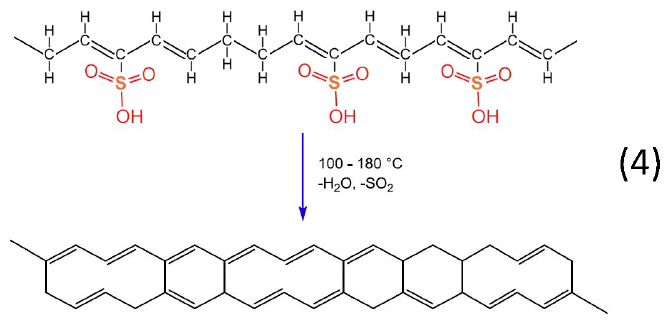
Figure 13. Chemical reaction of desulfonation accompanied by crosslinking among the hydrocarbon polymers.